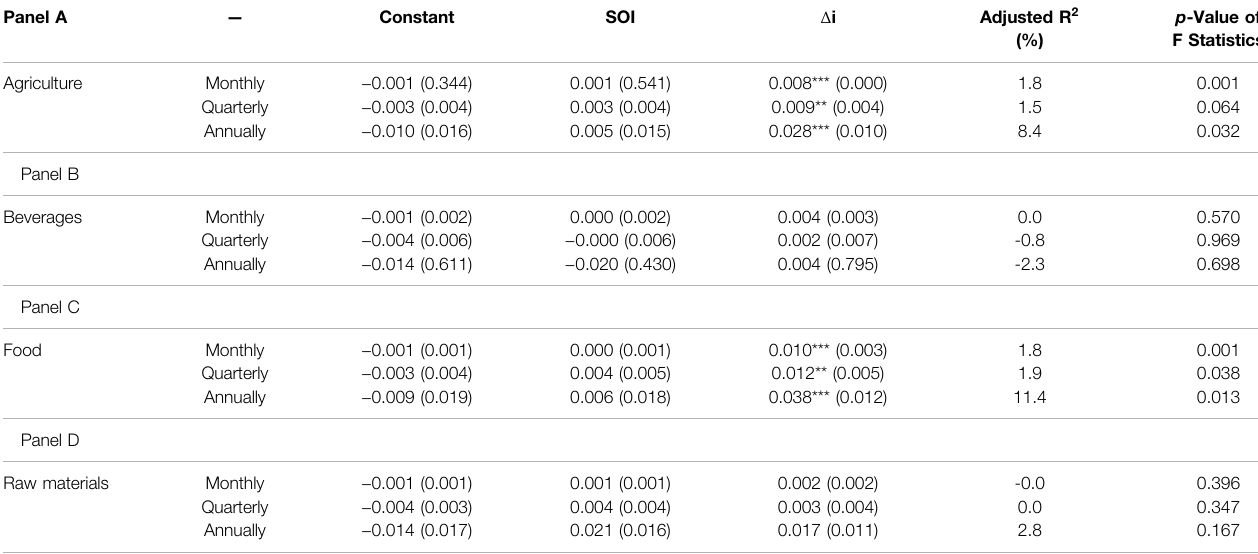
TABLE 2 | Estimated results of regression